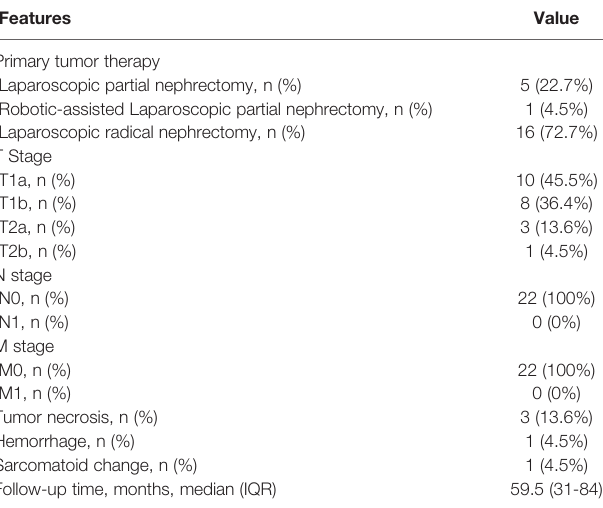
TABLE 6 | Treatment and pathological outcomes. Features